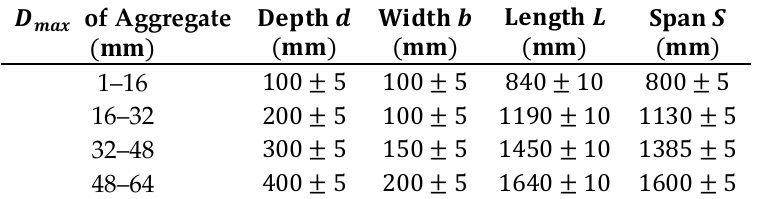
Figure 1. Experimental set-up for three-point bending tests on universal testing machines: ( a ) specimen with d = 100 mm on MTS machine after final failure; ( b ) testing set-up on Baldwin machine for specimens with d = 200, 300, and 400 mm. Table 1. Specimen sizes considered in the experimental campaign according to